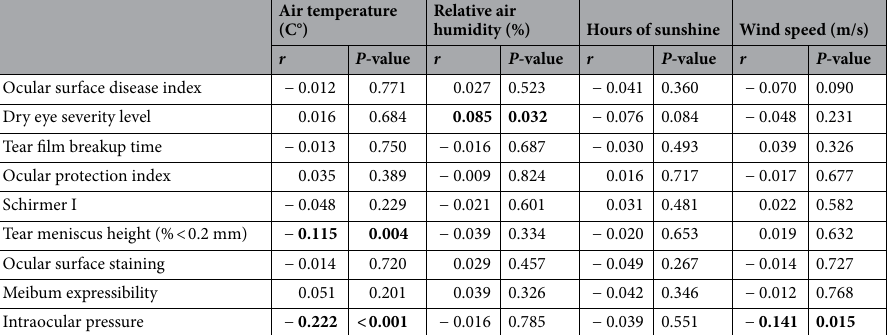
Table 3. Correlations between weather report data and symptoms and signs of DED. r Pearson correlation, DED dry eye disease; Bold font = statistically significant.